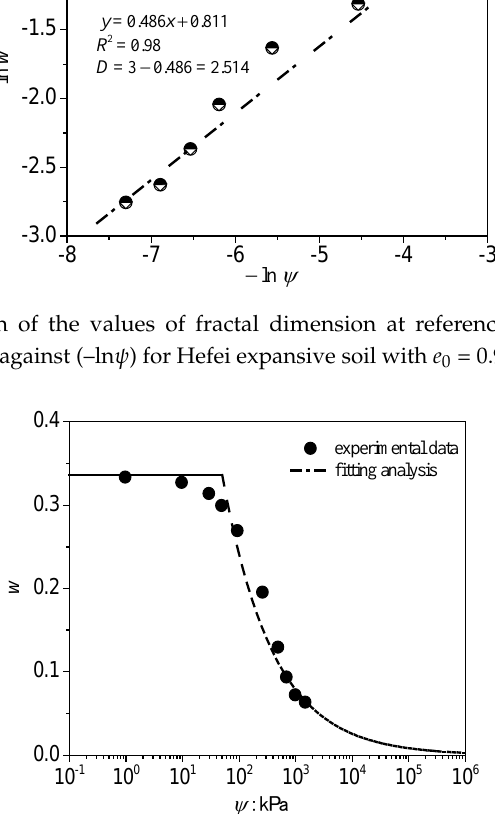
Figure 7. Determination of air-entry values at reference state through fitting Equation (12) to the experimental SWCCs for Hefei expansive soil with e 0 = 0.915.